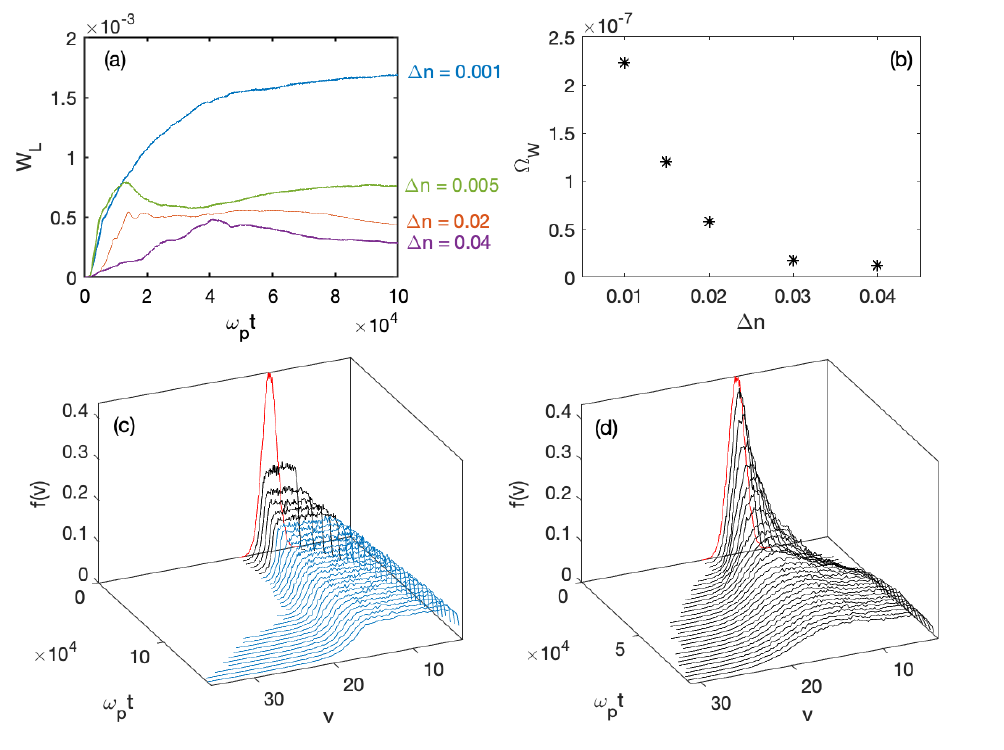
Figure 5. ( a ) Variation with time of the wave energy density W L = ∑ k | E k | 2 , for different average levels of density fluctuations ∆ n = 0.001, 0.005, 0.02 and 0.04. ( b ) Corresponding variations with ∆ n > ∆ n s of the normalized rate of growth Ω W of the wave packets. ( c , d ) Variations with time of the beam velocity distributions f ( v ) for a quasi-homogeneous ( ∆ n = 0.001 ) and a strongly inhomogeneous ( ∆ n = 0.04 ) plasma, respectively; the initial distributions are labeled in red; in ( c ), the part presented in blue corresponds to a process of beam acceleration due to wave decay and not to density homogeneities. Main parameters are the following: v b / v T = 14, ∆ v b / v b = 0.08, n b / n 0 (cid:39) 2.5 × 10 − 5 . All variables are